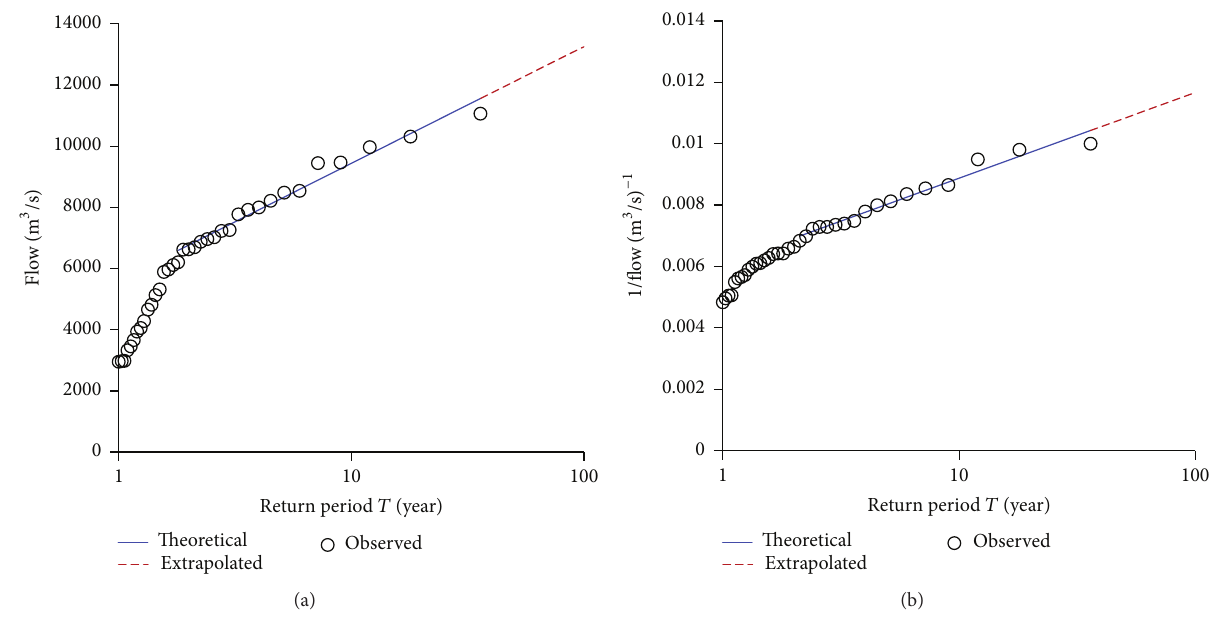
Figure 3: POT events in exponential quantile plots for (a) high flows and (b) low flows of 1-day aggregation level. The regression line is the fitted